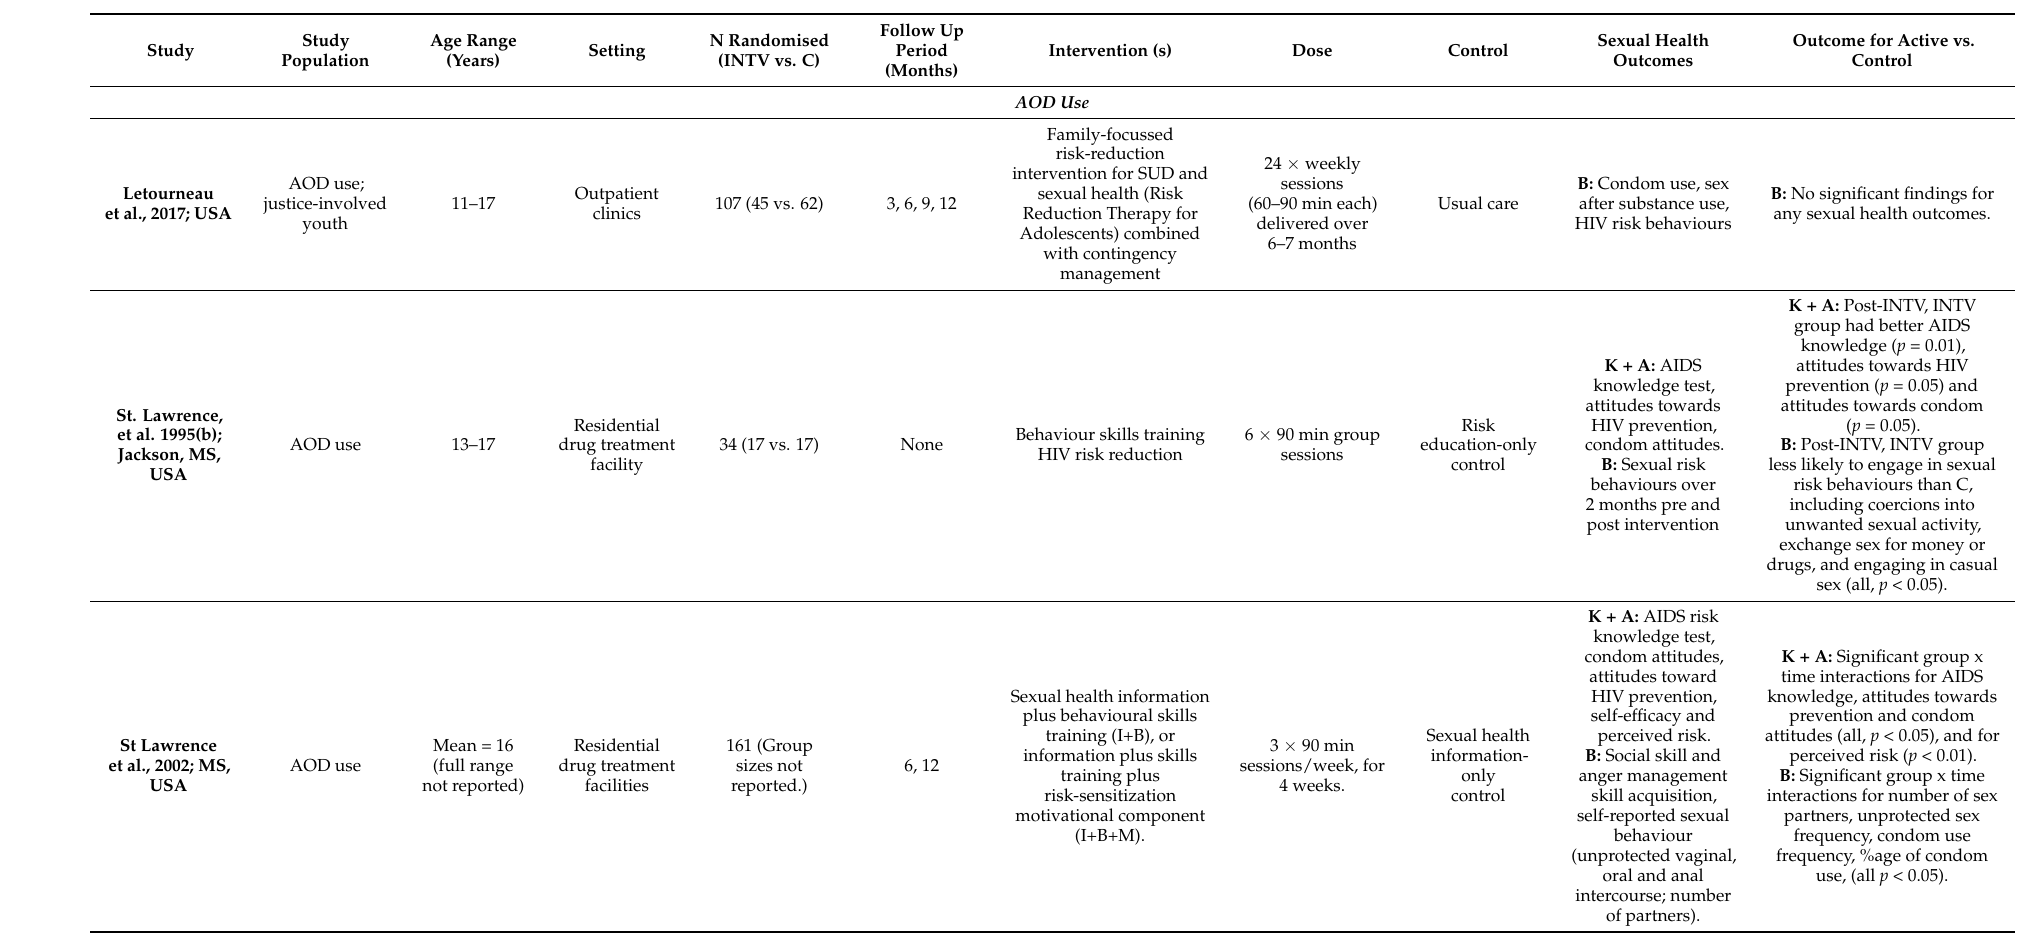
Table A1. Characteristics of included